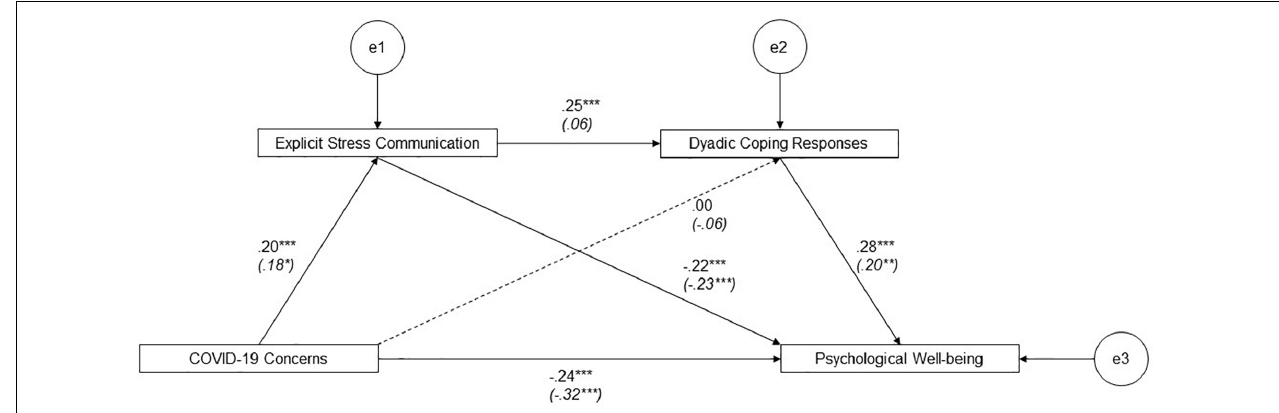
FIGURE 2 | Serial mediation model for satisfied vs . dissatisfied partners. Path coefficients are standardized estimates. Dissatisfied partners’ coefficients appear in brackets. * p = 0.05; ** p < 0.01; *** p ≤